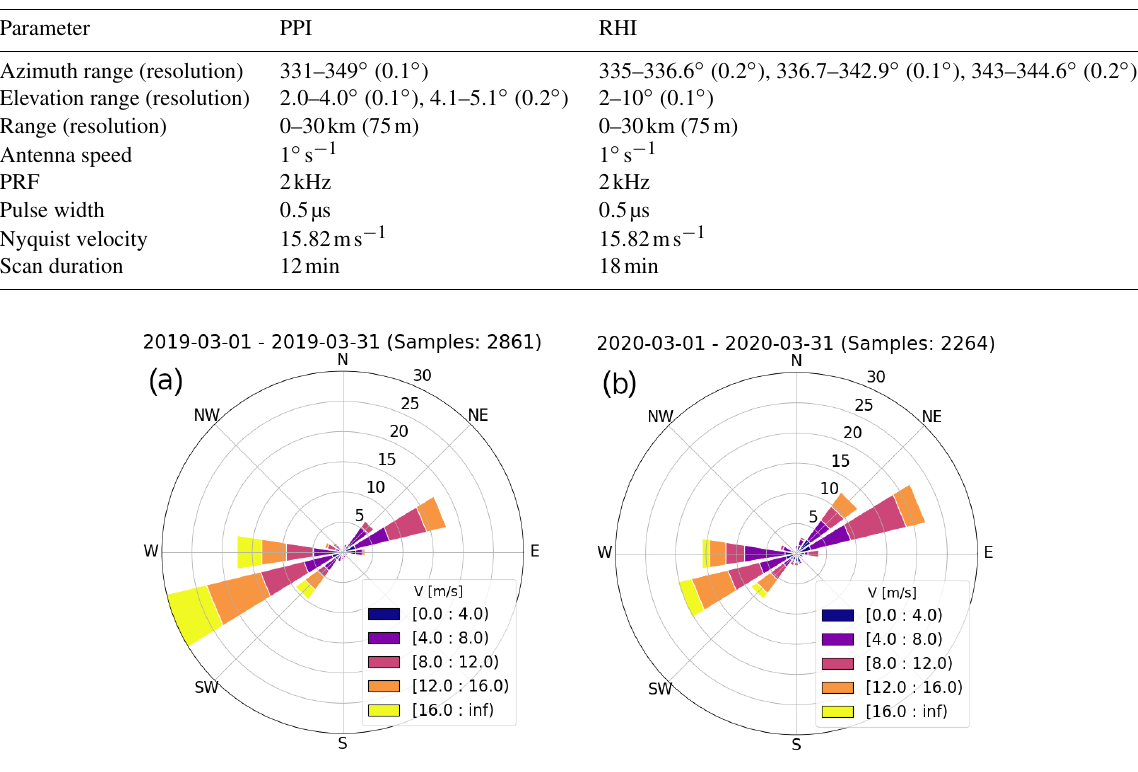
Figure 2. Wind rose plots showing the wind speed and direction distribution for March 2019 (a) and 2020 (b) at an altitude of 874m. The measurement data are retrieved from a nearby wind profiler (47 . 69 ◦ N, 8 . 62 ◦ W) in the district of Schaffhausen. The altitude of the wind measurements is comparable to the altitude of the nacelles of the wind turbines, and the horizontal distance to the turbines is about 8 . 8km. The colors indicate the wind speed intervals in a bin width of 4ms − 1 .